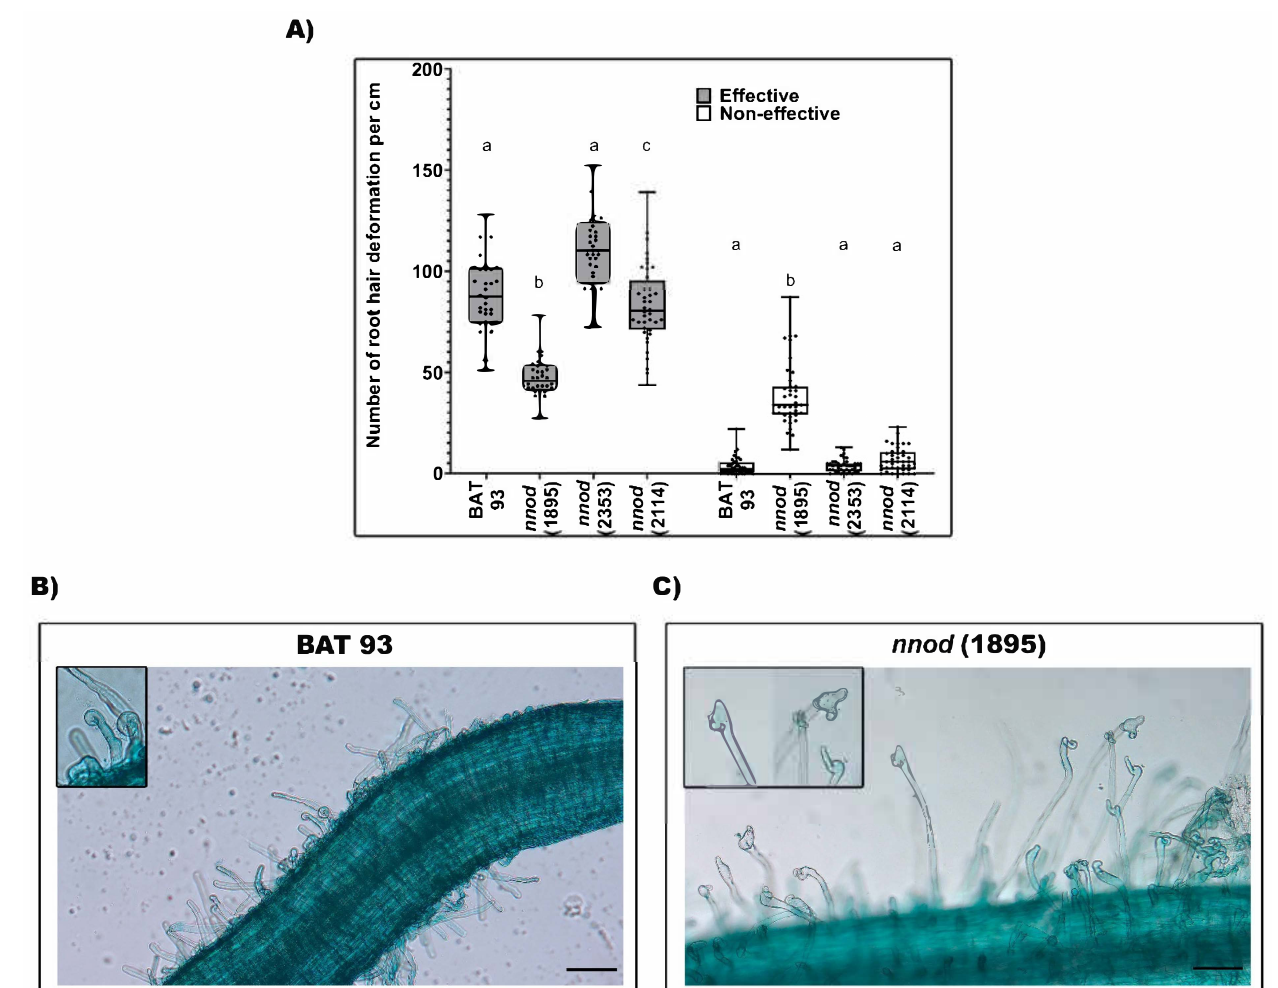
Figure 4. Response to rhizobia infection of WT and nnod (1895) mutant inoculated with R. etli CE3/pGUS. ( A ) Rhizobia-induced, effective or non-effective, root hair deformations were quantified at 25 dpi. Two biological replicates per genotype were analyzed by counting the root hair deformation in 20 root segments (1 cm) from each inoculated root. In box plots, horizontal box side represents the first and third quartile, while the outside whiskers represent the minimum and maximal values. Different lower-case letter from each set of values (effective and non-effective root hair deformations) indicates significant difference according to one-way analysis of variance (ANOVA) ( p ≤ 0.0001). Representative image of rhizobia-induced root hair deformations in WT-inoculated roots; insert shows root hair curling and hook-type effective root hair deformations ( B ) and in nnod (1895)-inoculated roots; insert shows aberrant spatula-like non-effective root hair deformations ( C ). Bar = 100 µ